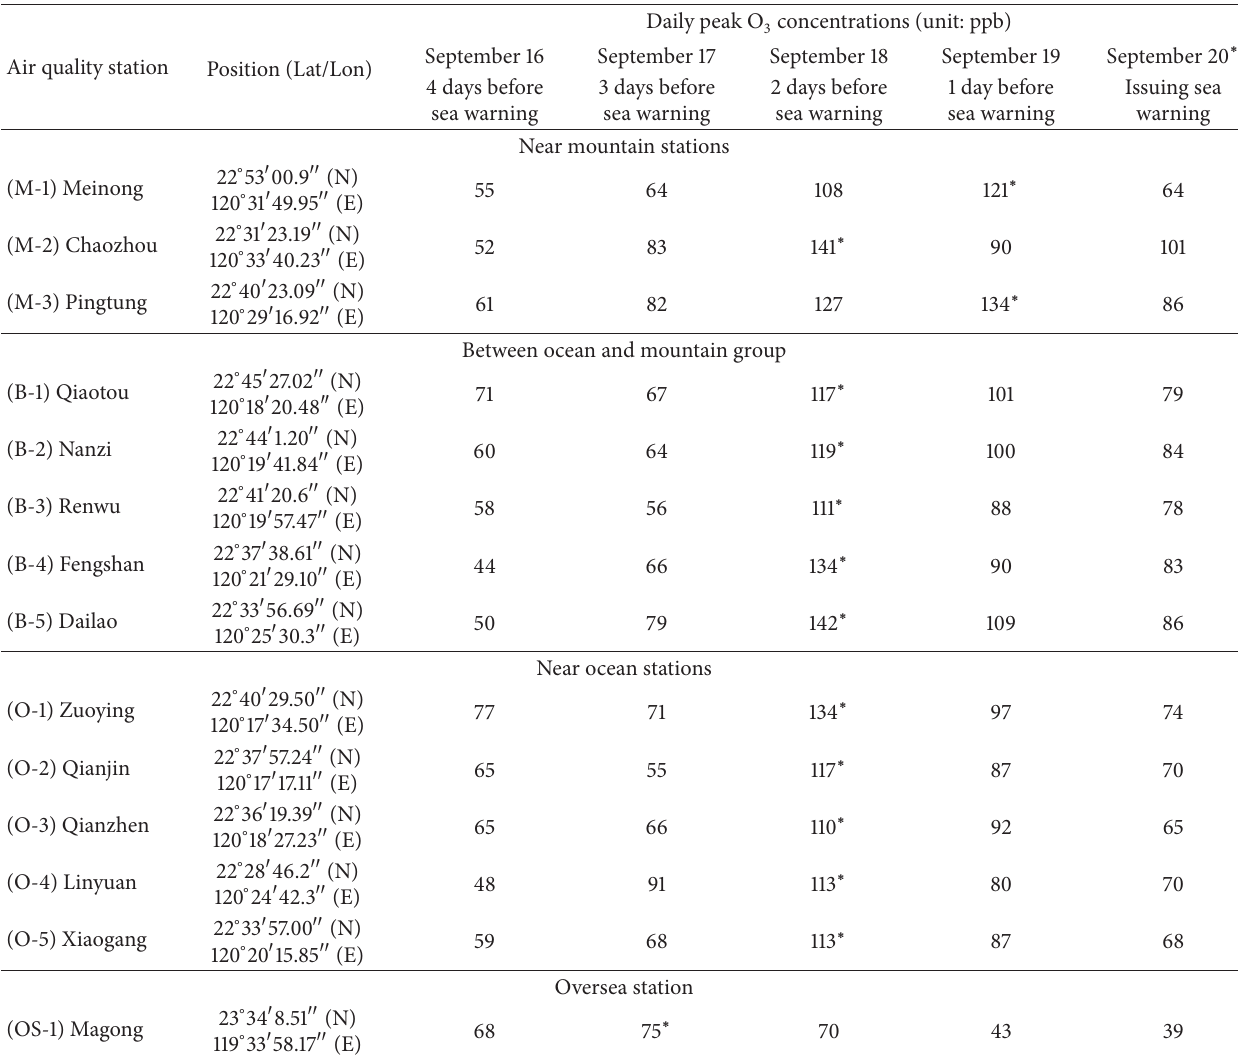
Table 4: Ozone daily peak concentration observed using air quality monitoring stations located in Southern Taiwan before and after the invasion of typhoon Usagi (September 16 ∼ 20,